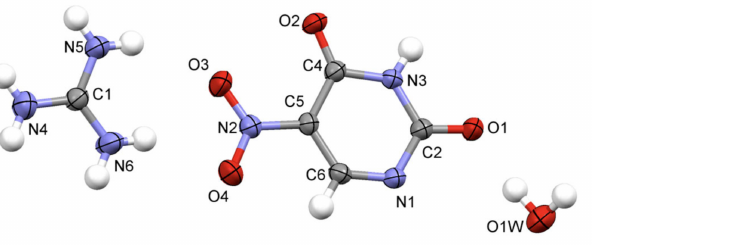
Figure 20. Asymmetric unit of guanidinium 5-nitrouracilate monohydrate (XVIII) . Displacement ellipsoids are drawn at the 50% probability